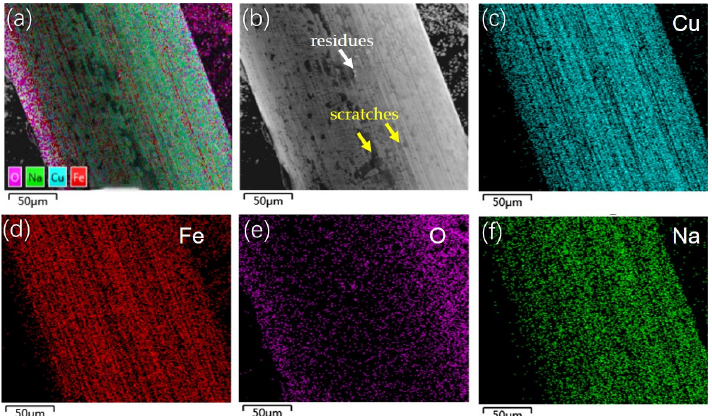
Figure 16. SEM and EDS images of straight BCSFs: ( a ) EDS imagine; ( b ) SEM imagine; ( c ) Cu; ( d ) Fe; ( e ) O; ( f ) Na. Materials 2023 , 16 , x FOR PEER REVIEW